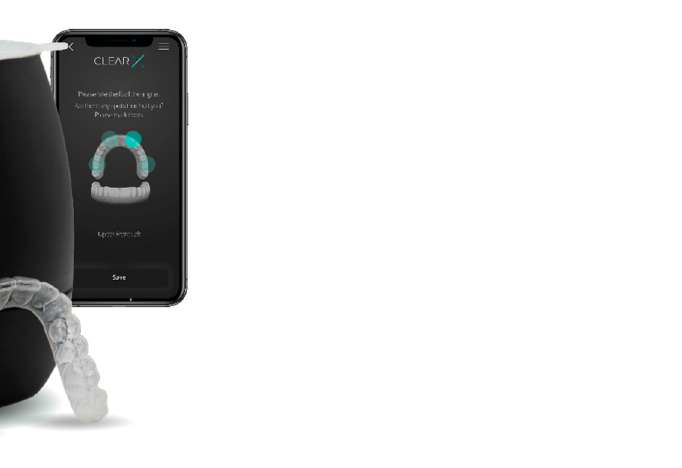
Figure 6. Superimposition of the typodont’s scans using 3Shape Ortho System software (Ortho Analyzer) and the amount of tooth movement was measured for each step.